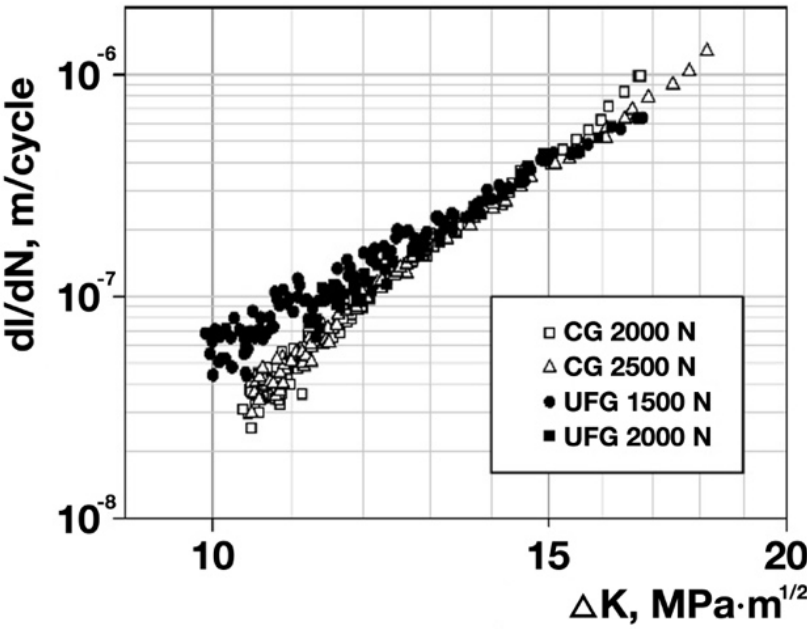
Figure 4. Straight-line portion of the kinetic diagrams of fatigue fracture for CG Ti (bright dots) and UFG Ti (dark dots) at different values of the load ∆ P, N. Table 3. Paris equations describing the straight-line portion of the kinetic diagrams of fatigue fracture for CG and UFG Ti.